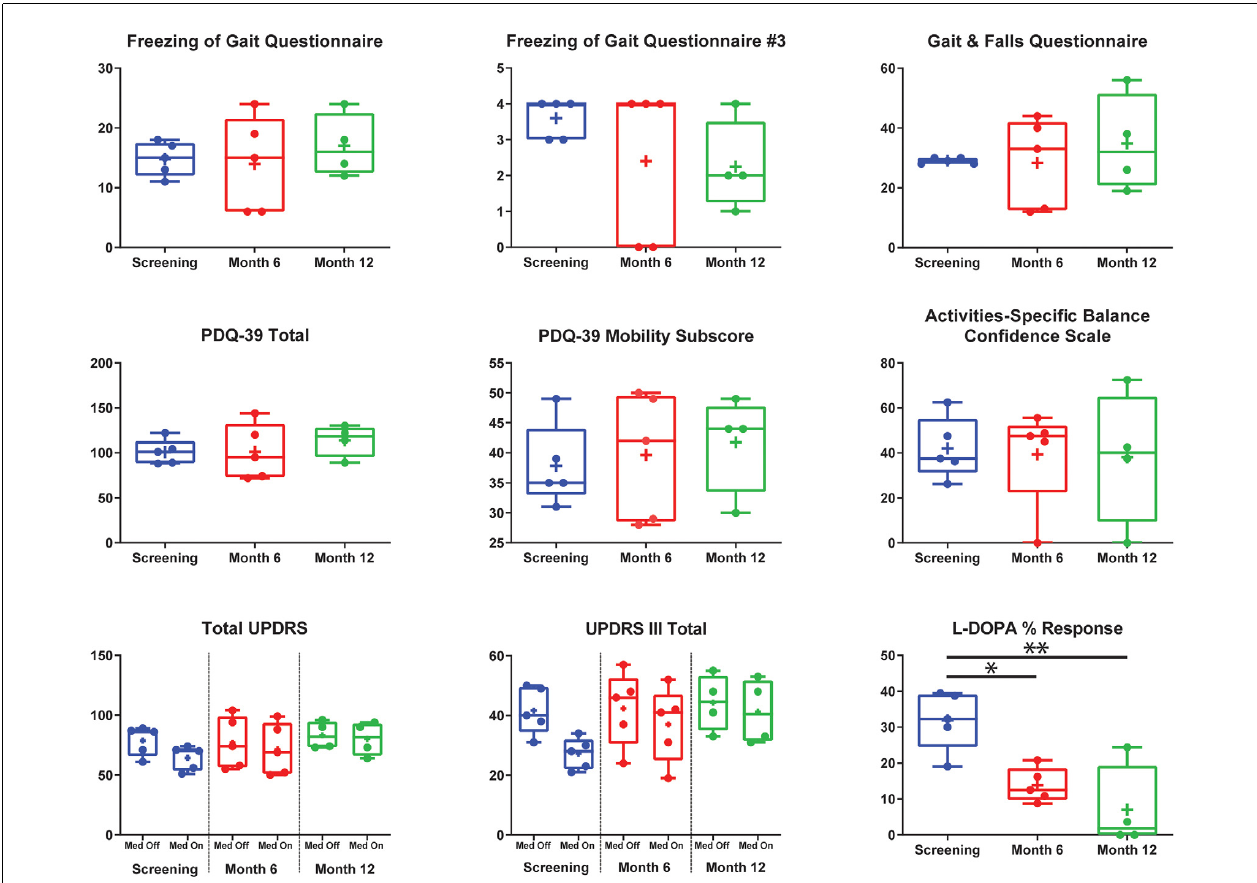
FIGURE 3 | Group summary of clinical outcome measures. This figure addresses the entire cohort before deep brain stimulation (DBS) implantation ( blue ) after 6 ( red ) and 12 ( green ) months post-implantation on the Freezing of Gait Questionnaire (FOGQ), FOGQ#3, Gait and Falls Questionnaire (GFQ), Parkinson’s disease (PD) Quality of Life Questionnaire—3 (PDQ-39) total, PDQ-39 mobility, Activities-Specific Balance Confidence Scale (ABC), total Unified Parkinson’s Disease Rating Scale (UPDRS), UPRS-III, and L-DOPA percent response. All graphs are standard box plots, with dots indicating individual scores, and plus signs indicating means. FOGQ question #3 was “Do you feel that your feet get glued to the floor while walking, making a turn or when trying to initiate walking (freezing)?” Off Med , off dopaminergic medication; On Med , on dopaminergic medication. All clinical measures were performed on globus pallidus internus (GPi) open-loop DBS. Pedunculopontine nucleus DBS was not activated during secondary outcome measures, except at month 12 for subject 5. ∗ p < 0.05, ∗∗ p < 0.01.